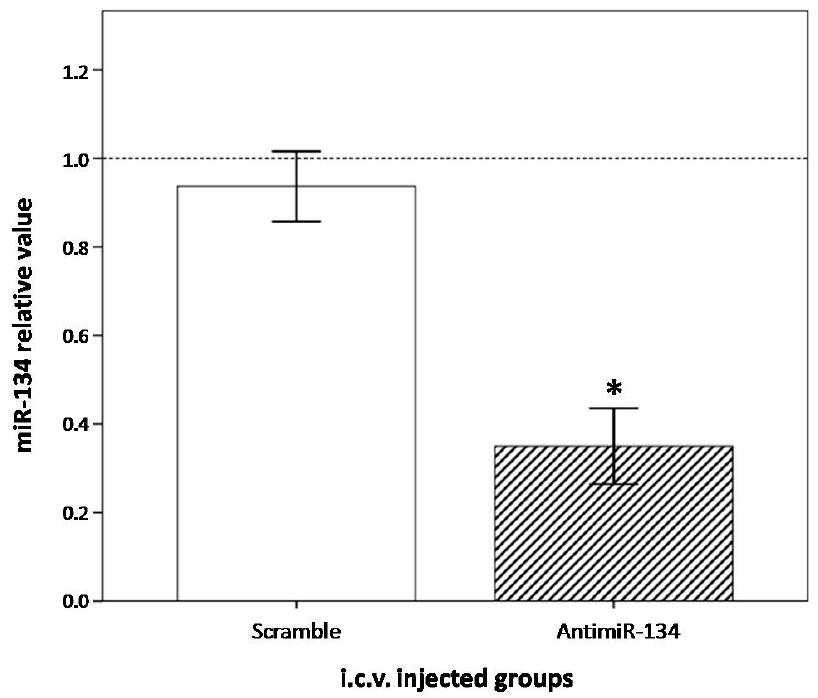
Figure 2. Knocking down on striatal miR-134 by Neuromag-complexed AntimiR-134 oligos. The content of miR-134 in the striatum determined by real-time quantitative polymerase chain reaction (RT-qPCR), at seven days after i.c.v. injections. miR-134 results in groups injected with AntimiR-134 or the negative control Scramble first normalized with RNU6B ( ∆ Ct), and them compared to those obtained in control animals ( ∆∆ Ct), arbitrarily assigned as 1.0 (100% expression). Bars represent mean ± SEM regarding miRNA relative value. * P < 0.05. n = 5 per group.